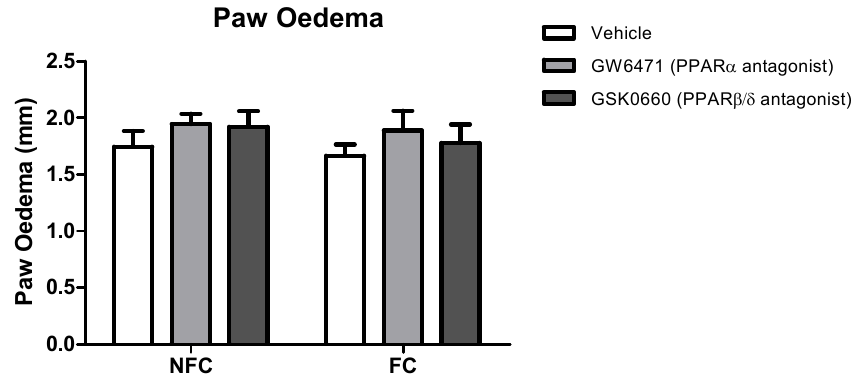
Figure 1. Effects of the systemic administration of selective PPAR α and PPAR β / δ antagonists on formalin ‐ evoked nociceptive behaviour in non ‐ fear conditioned (NFC) and fear conditioned (FC) rats. Composite pain score was calculated as (pain 1 + 2 × [pain 2])/total duration of analysis period (see Materials and Methods for further information). Data (mean ± S.E.M) are represented in 3 ‐ min time bins ( n = nine rats per group). According to a repeated measures ANOVA ( p < 0.05), * significant main effect of fear conditioning.